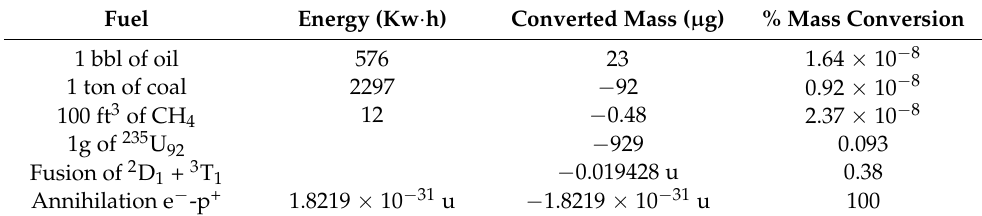
Table 1. Mass conversion factors for various energy production